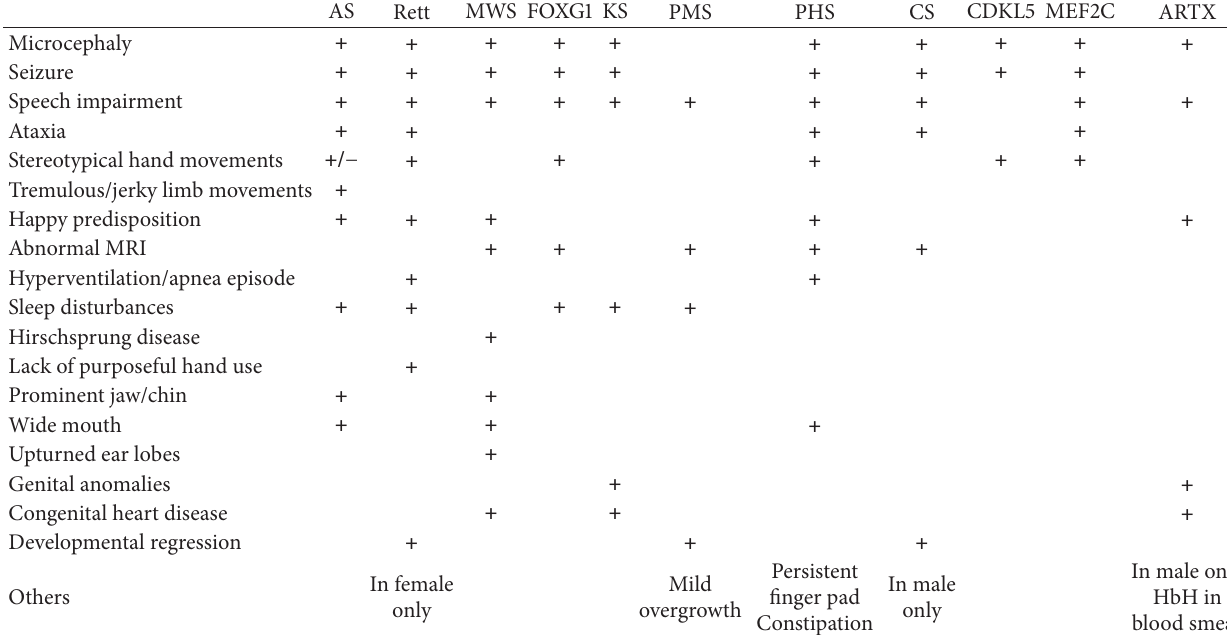
Table 2: Differentiating clinical features among Angelman-like